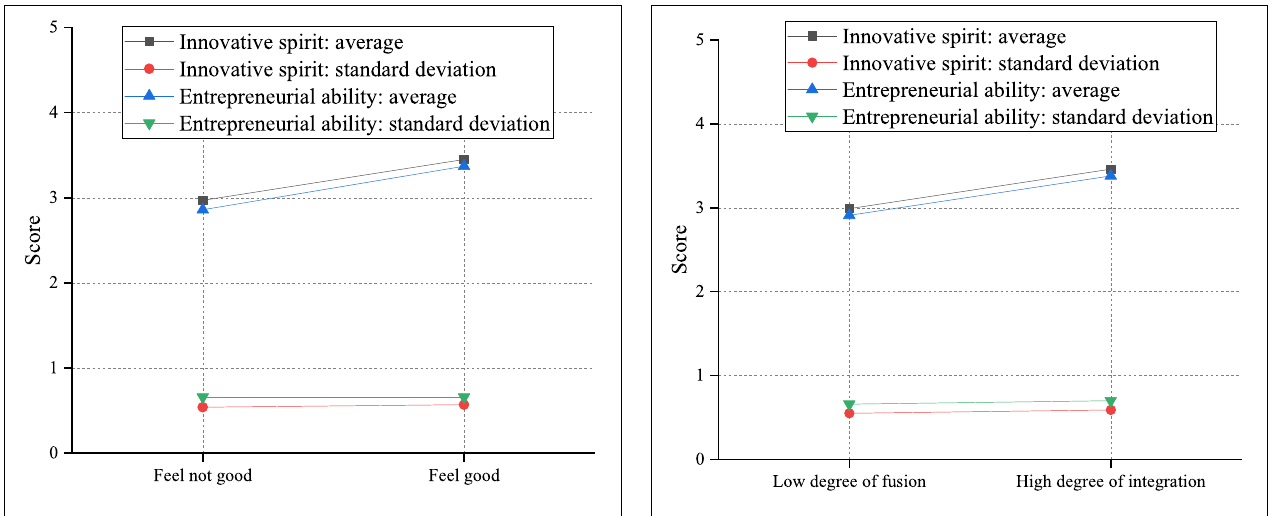
FIGURE 15 | Impact of the integration of innovation and entrepreneurship courses with other courses on the innovation and entrepreneurship ability of college